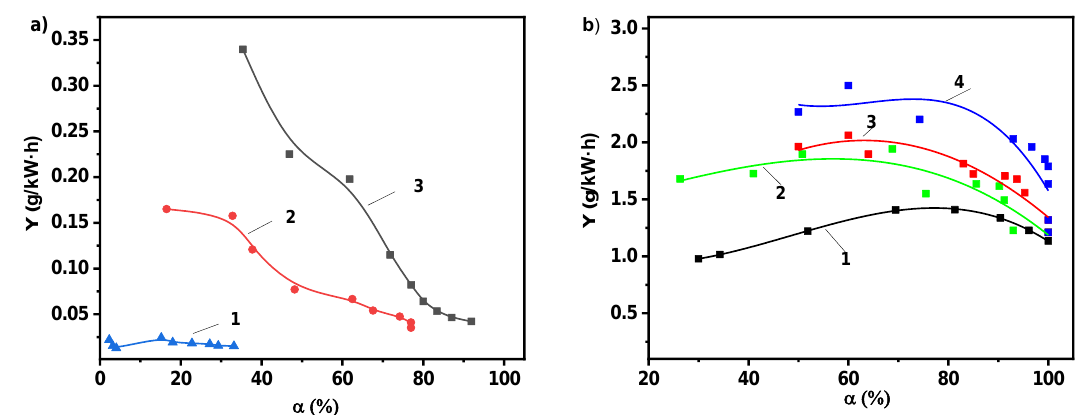
1000.050.100.150.200.250.300.35 k g / ( Y Figure 6. Dependence of the energetic efficiency of the decomposition process on the degree of dye destruction: a — UV photolysis in the presence of catalysts TiO 2 -PMM (1), TiO 2 -PMMH (2) and TiO 2 - PAMMH (3); b — DBD (1), DBD + TiO 2 -PMM (2), DBD + TiO 2 -PMMH (3) and DBD + TiO 2 -PAMMH (4). Figure 7. The expended power in the discharge (1) and efficiency of RhB degradation (2) vs. discharge current frequency (2a—DBD; 2b—DBD in the presence of the photocatalyst TiO 2 -PMMH and 2c—DBD in the presence of the photocatalyst TiO 2 -PAMMH).